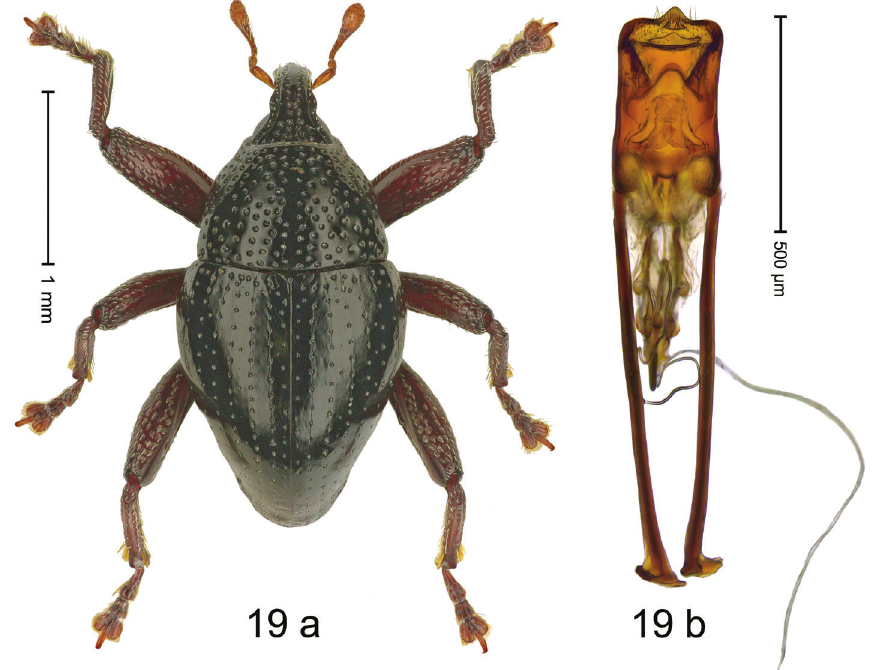
Figure 19. Trigonopterus rosichoni sp. nov., holotype a habitus b